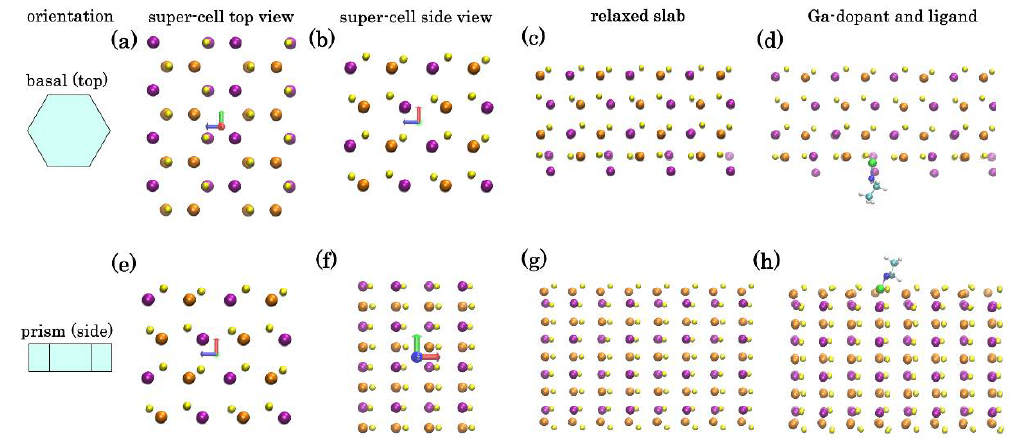
Figure 6. Ordered CIS orthorhombic model of the top or basal ( a – d ) and side or prism ( e – h ) surfaces of hexagonal nanoparticle: idealized super-cell top view ( a , e ) and side view ( b , f ) and density functional theory (DFT) relaxed atomic structures of the pure surface slabs ( c , g ) and with Ga dopant and –NH–C 2 H 5 passivating group ( d , h ). Legend: In (purple), Cu (orange), Se (yellow), Ga (green), N (deep blue), C (light blue), and H